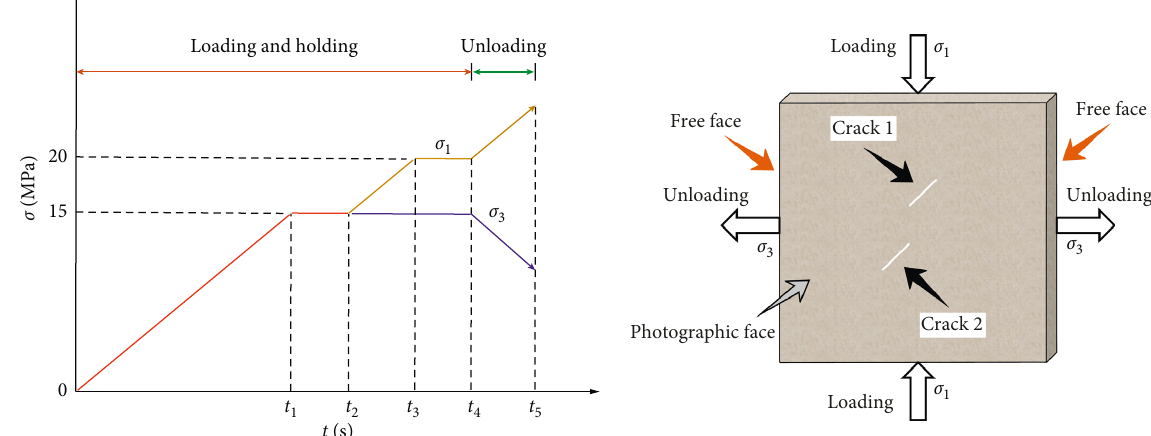
Figure 14: Sketch of the experimental stress path.